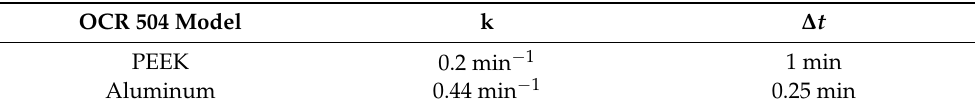
Table 2. Parameters used to reconstruct the sensor internal temperature T s according to the material of the radiometer components.